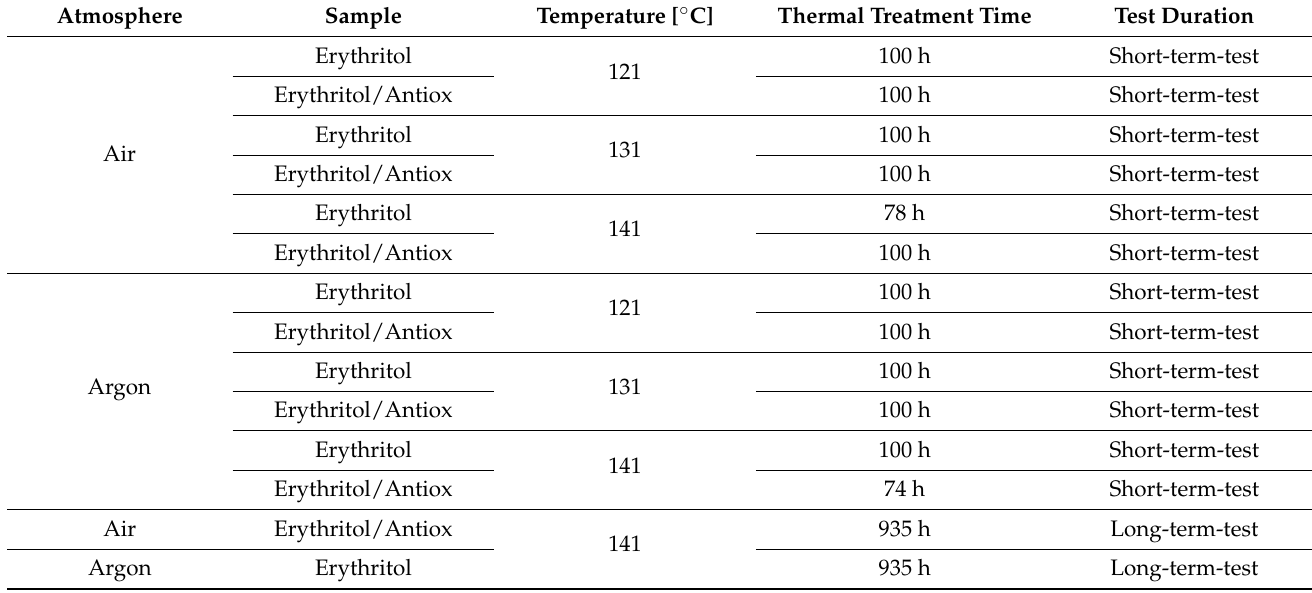
Table 1. Summary of the performed